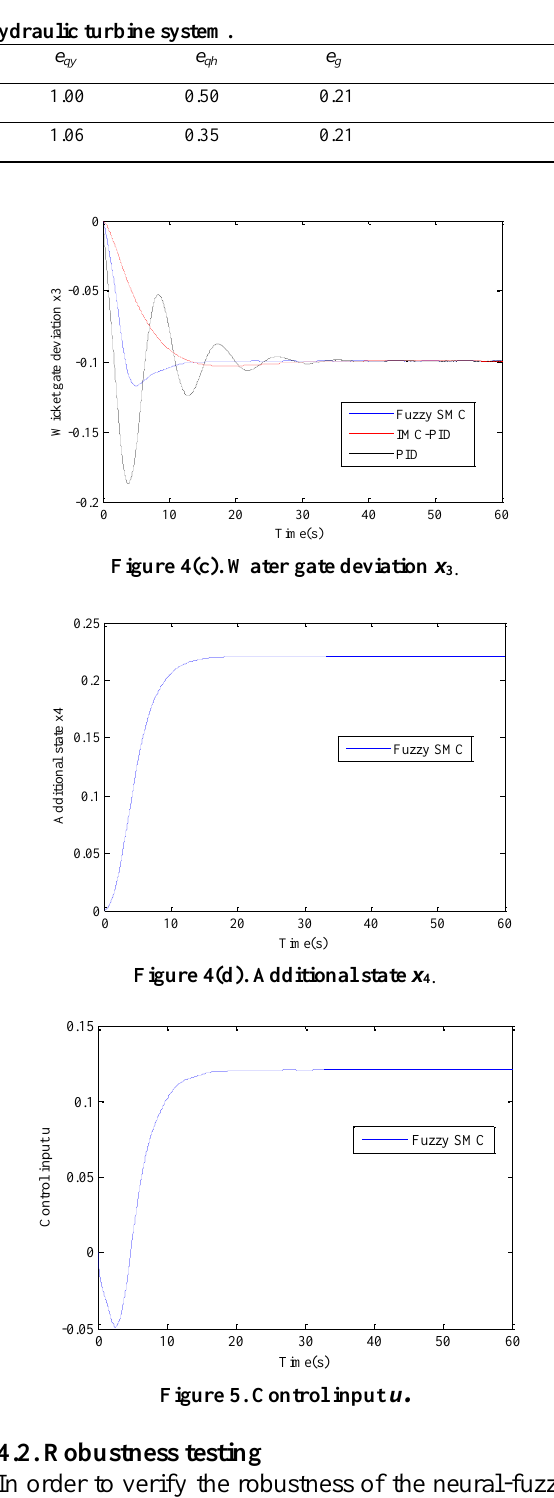
Figure 5. Control input